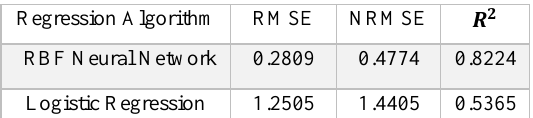
Figure 5. Effective information layers: Land use